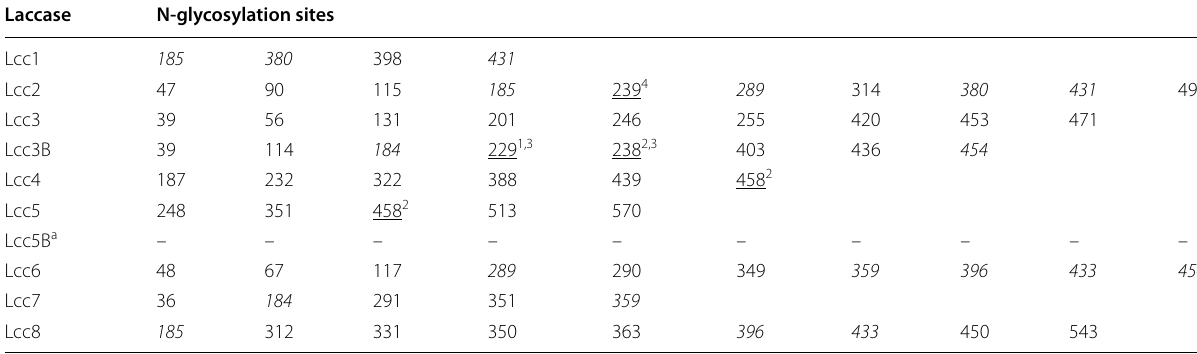
a Lcc5B does not present peptide signal and may not pass through N-glycosylation process. Italic numbers: site similar to other laccases from Peniophora sp. CBMAI 1063. Underlined numbers: site similar to laccases from other